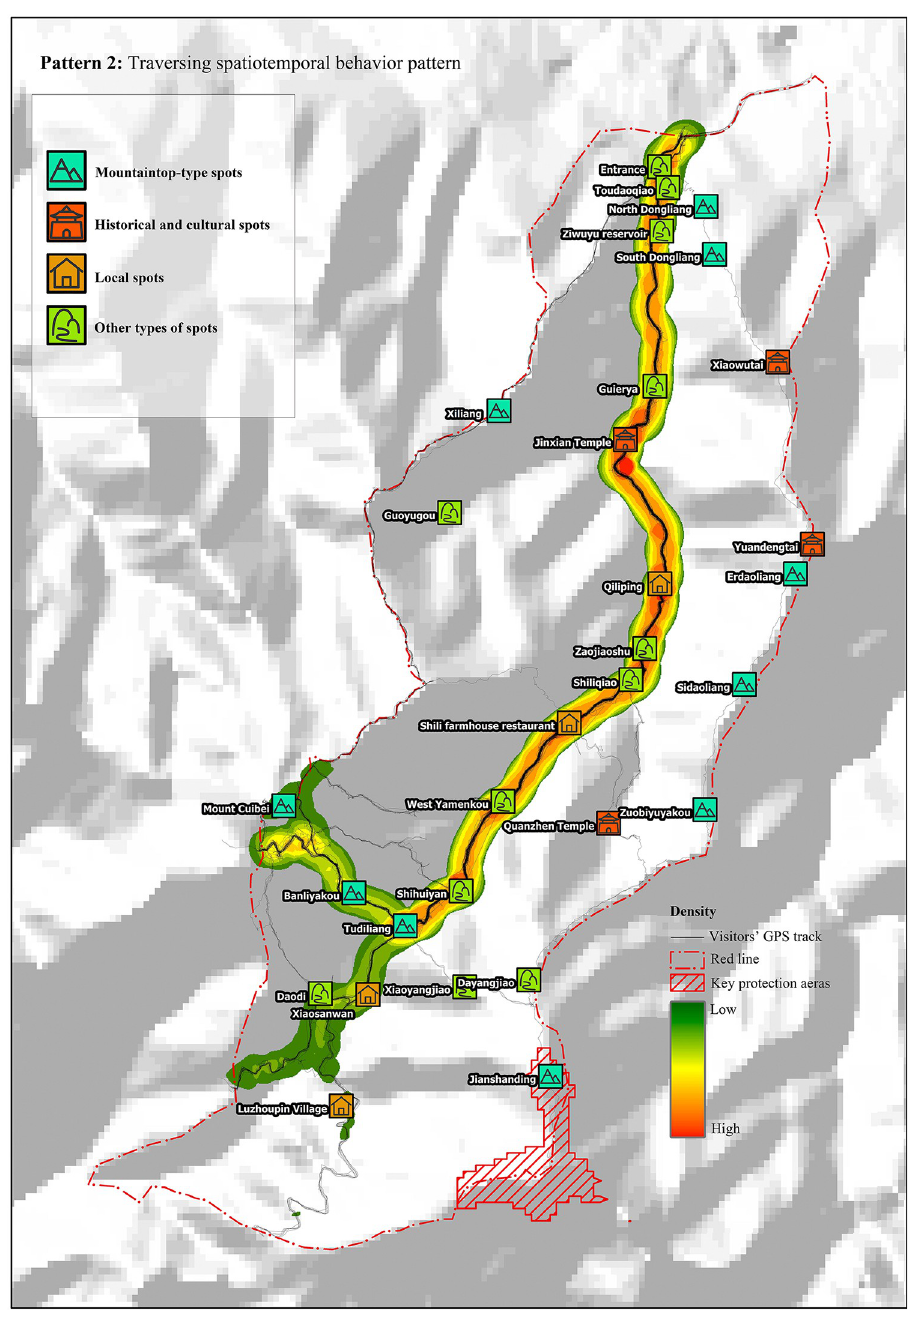
Fig 3. Traversing spatiotemporal behavior pattern. Reprinted from [https://www.usgs.gov/centers/eros/data] under a CC BY license, with permission from [United States Geological Survey], original copyright [2000]. and native villages, respectively. Among the four first-level codes, natural landscape witnessed the maximum number of visits (57.55%), followed by mountaineering expeditions (25.46%) historic culture (11.60%), and native villages (5.40%). The statistical results revealed that tour- ists visiting Ziwuyu were mainly passionate about natural landscapes and mountaineering expeditions, supplemented by the experience of historic cultures and native villages.